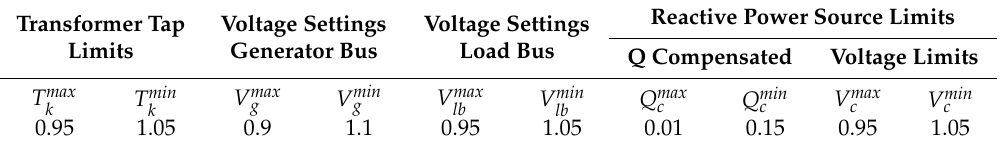
Table 1. Limiting values of control variables.